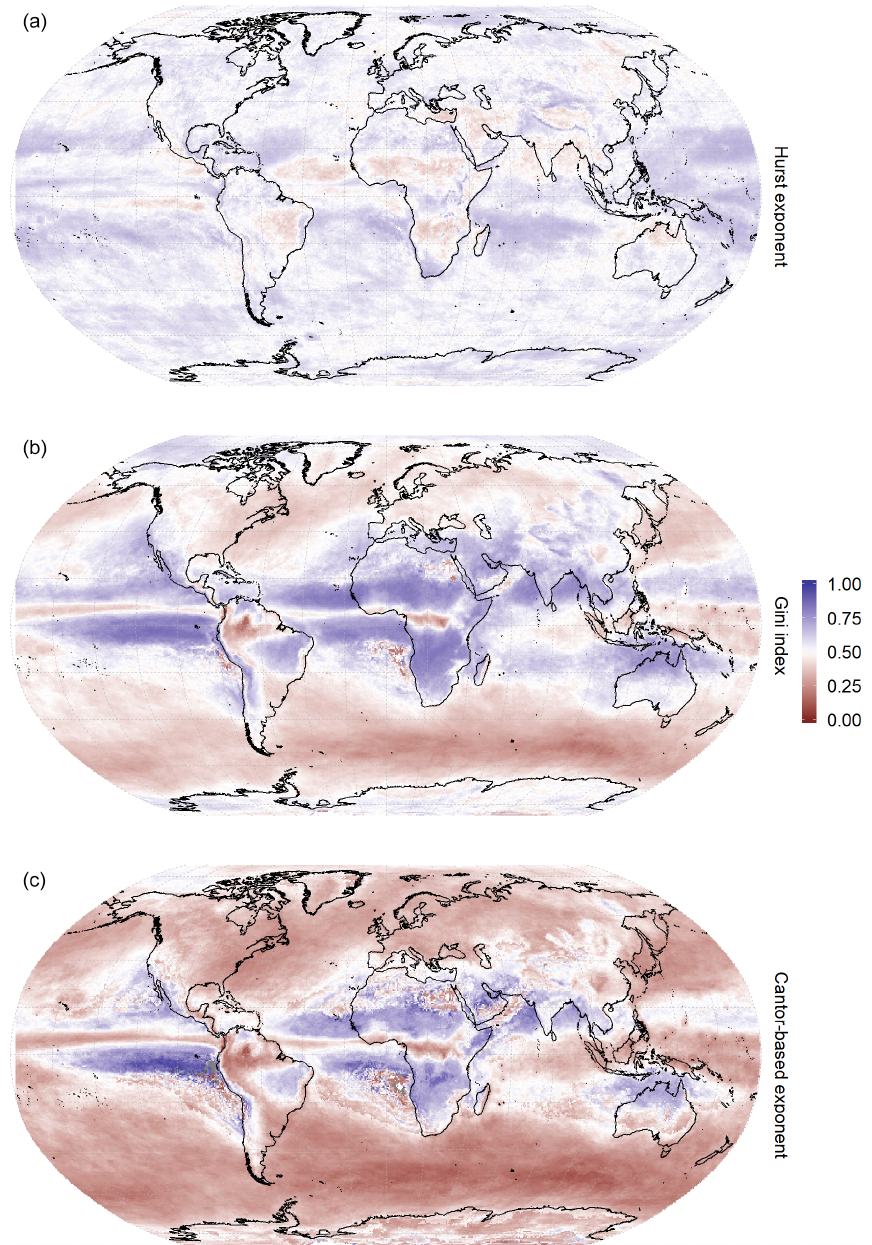
Figure 2. Spatial distribution of other fractal measures applied to dry spells: (a) Hurst exponent, (b) Gini index, and (c) Cantor-based